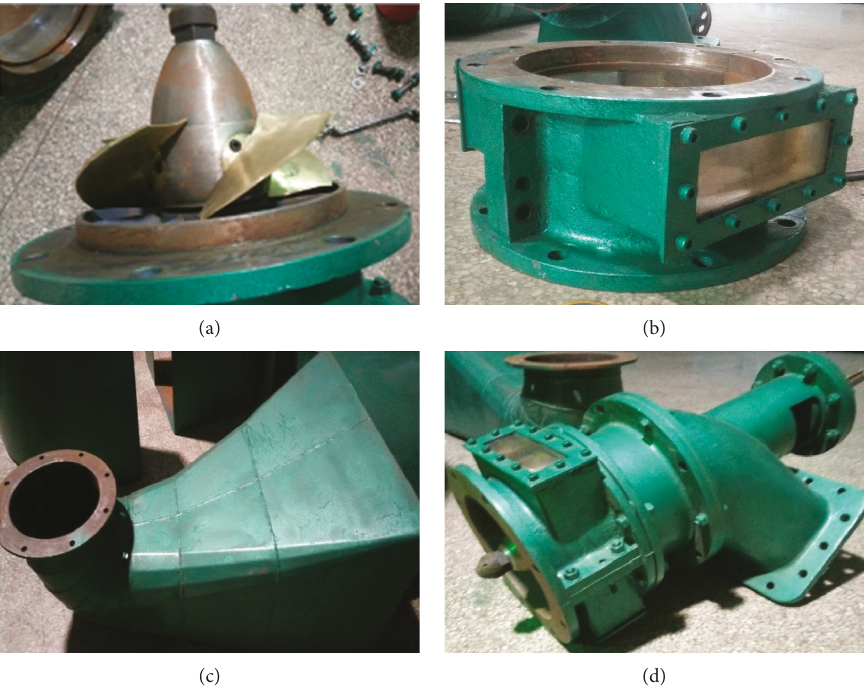
Figure 10: The device of the whole pump. (a) Blades. (b) Runner chamber. (c) Inlet passage section. (d) Pump device section.